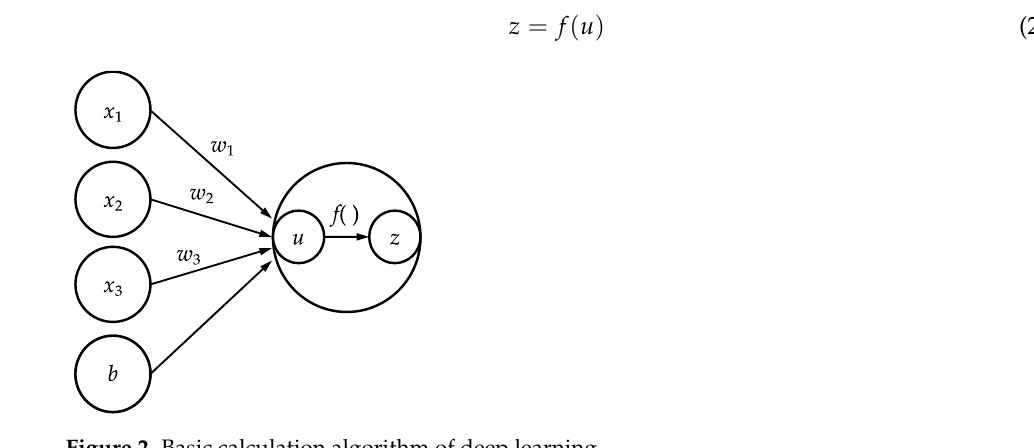
Figure 2. Basic calculation algorithm of deep learning.